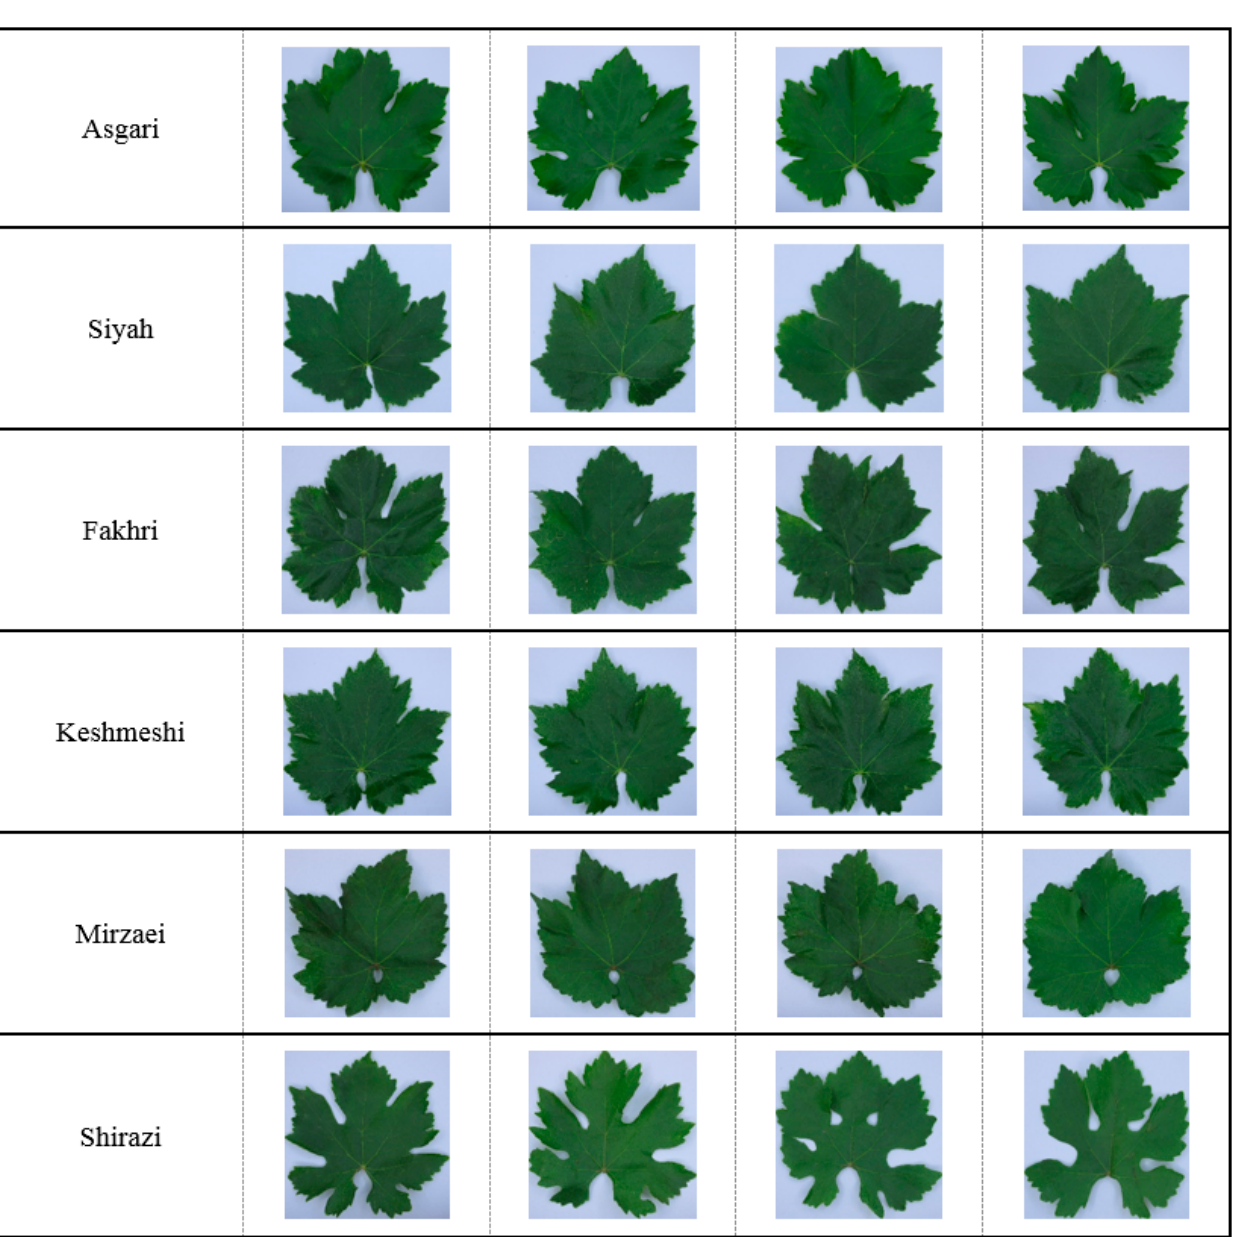
Figure 1. Representative true-to-type leaf images of the six grapevine cultivars under